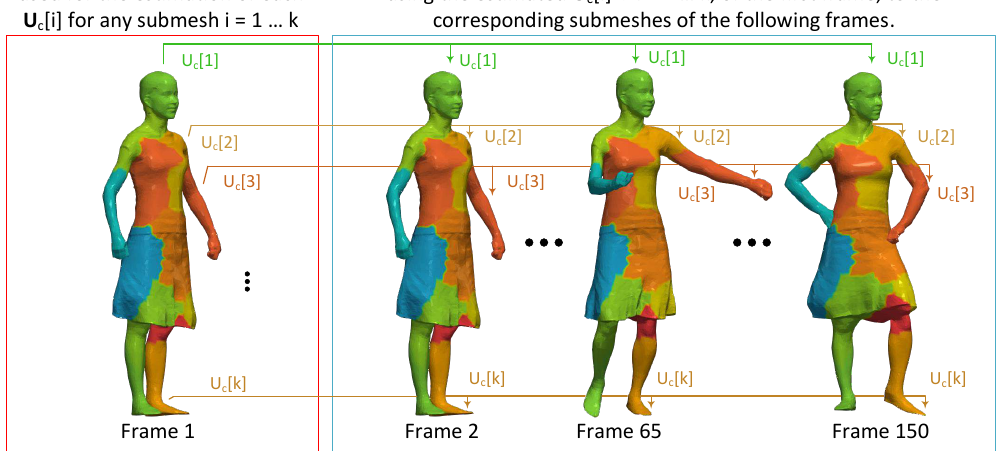
Figure 10. Parallel programming schema for high-performance coarse denoising of a 3D dynamic